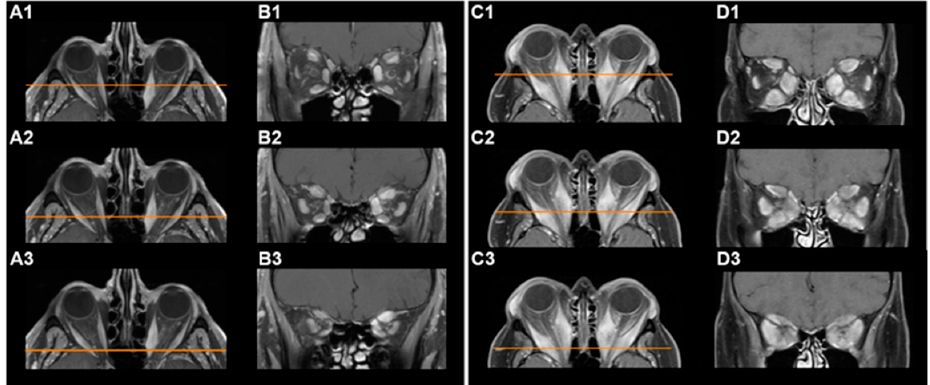
Figure 2. Magnetic resonance imaging (MRI) demonstrating not-increased or increased orbital muscle volume. ( A , B ): T1-weighted, contrast-enhanced MRI scans of the orbits of a bilaterally affected GO-patient with not-increased orbital muscle volume prior to decompressive surgery; axial images ( A1 – A3 ) with the orange line indicating the position of each corresponding coronal ( B1 – B3 ) image retrobulbar ( A1 , B1 ), at the orbital apex ( A3 , B3 ) and in between ( A2 , B2 ). ( C , D ): T1-weighted, contrast-enhanced MRI scans of the orbits of a bilaterally affected GO-patient with increased orbital muscle volume prior to decompressive surgery; axial images ( C1 – C3 ) with the orange line indicating the position of each corresponding coronal ( D1 – D3 ) image retrobulbar ( C1 , D1 ), at the orbital apex ( C3 , D3 ) and in between ( C2 , D2 ).